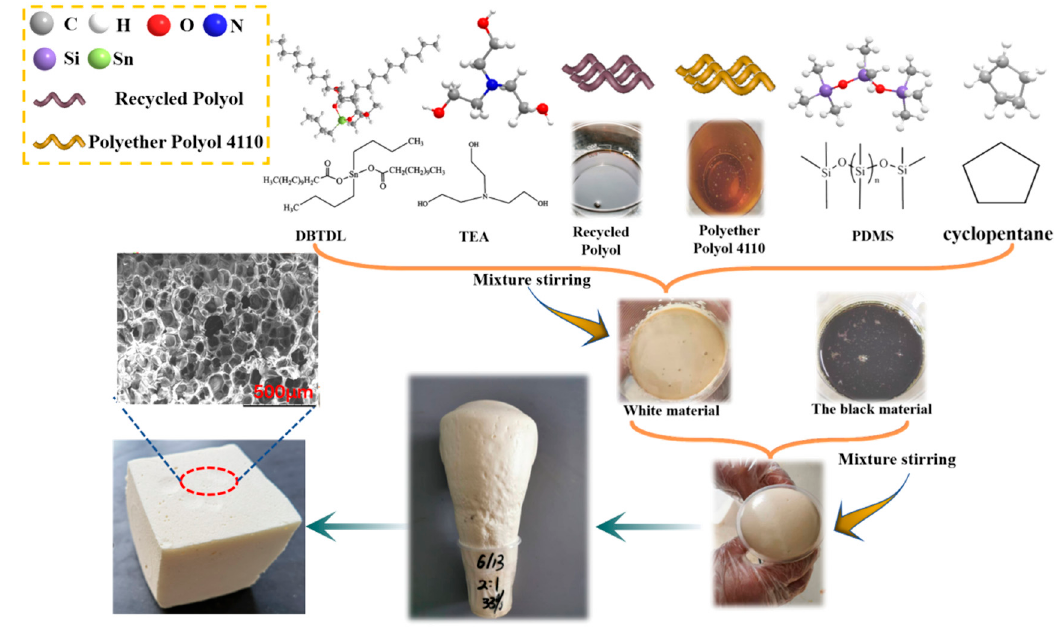
Figure 2. Flow of foaming process used for replacing some commercially available polyether polyols with recycled polyether polyols. Table 1. Foaming ratio of recycled polyurethane hard foam.